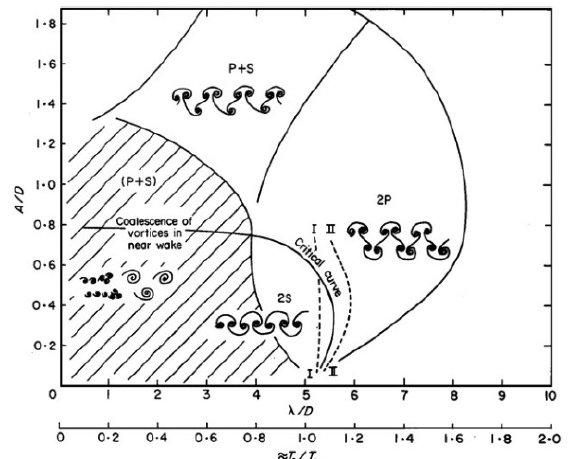
Fig. 3 . Map of vortex synchronisation patterns near the fundamental lock-in region, A/D is the amplitude ratio and  /D is the wavelength ratio. The critical curve represents the transformation from one mode of vortex formation to another. Curves I and II represent locations of a sharp jump of the forces (acting) on the body [4].